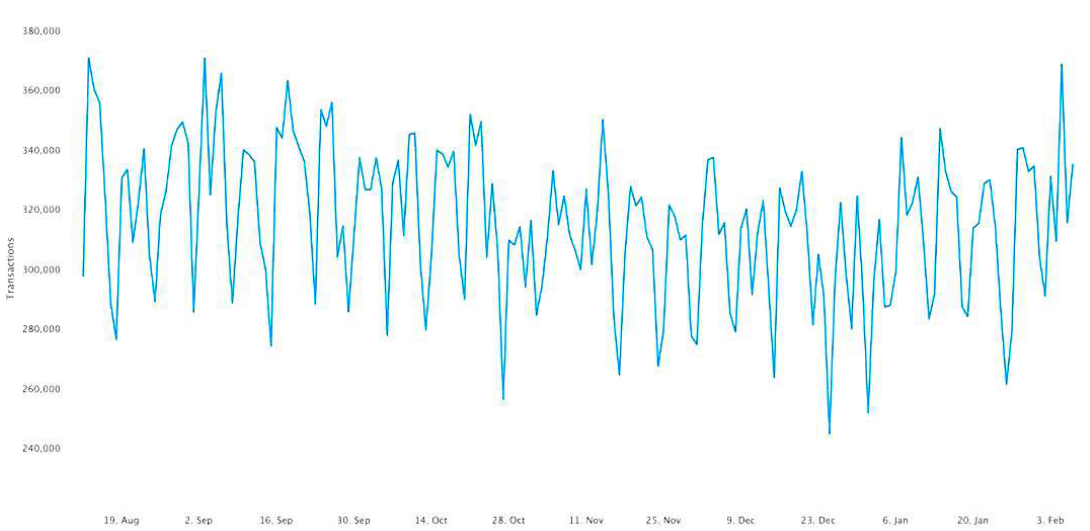
Figure 1. The number of daily confirmed Bitcoin